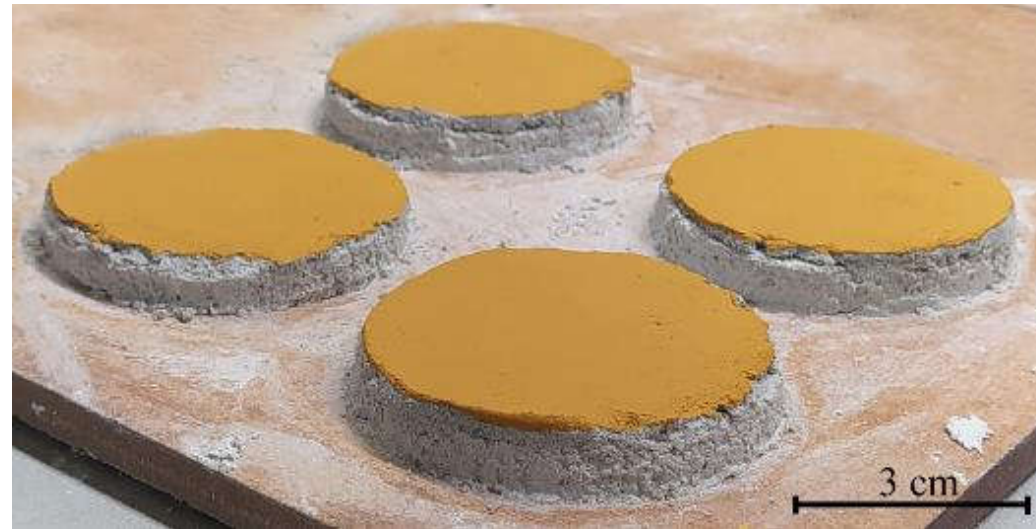
Figure 1. Laboratory developed wall painting specimens prior the consolidation.